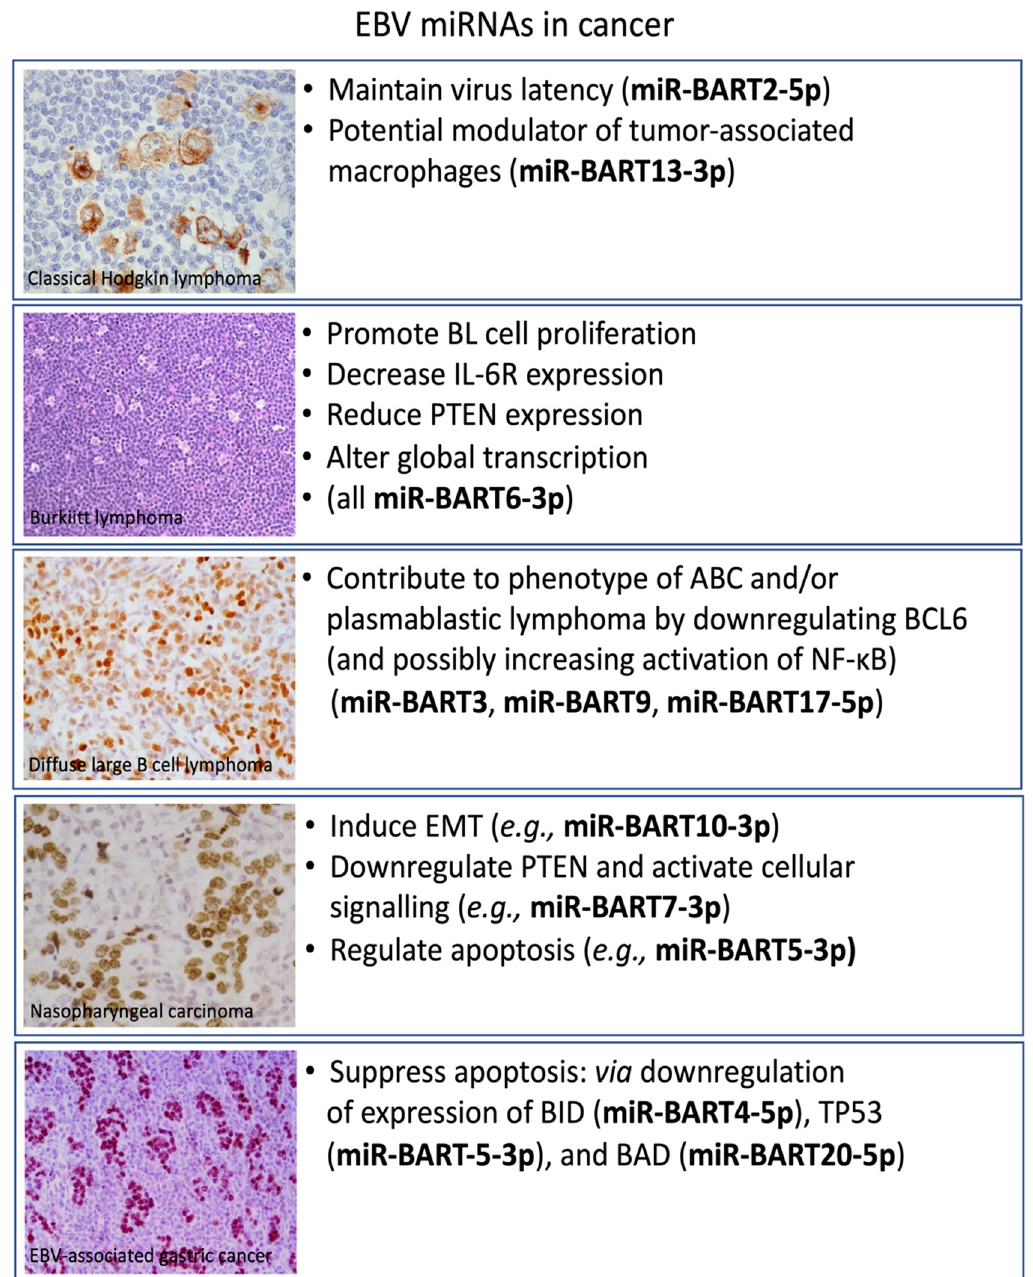
Figure 2. Functions of selected EBV miRNAs in the pathogenesis of the different EBV-associated malignancies. Depicted are EBV-positive classical Hodgkin’s lymphoma showing EBV-LMP1 expression in HRS cells. Burkitt lymphoma showing the typical starry sky appearance on H&E. EBNA2 expression is shown in a Lat III-expressing diffuse large B cell lymphoma. EBNA1 expression is depicted in the two major EBV-associated epithelial neoplasms, nasopharyngeal carcinoma, and gastric carcinoma.